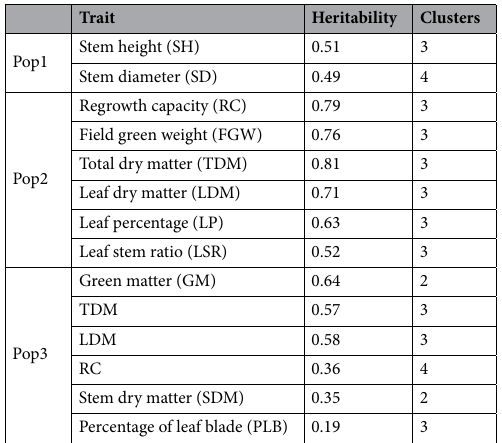
Table 1. Heritability and cluster configuration of each trait across the different traits separated according to the populations: (Pop1) cross between sugarcane commercial varieties, (Pop2) cross between a commercial variety and a genotype of Urochloa decumbens , and (Pop3) cross between a commercial variety and a genotype of Megathyrsus maximus